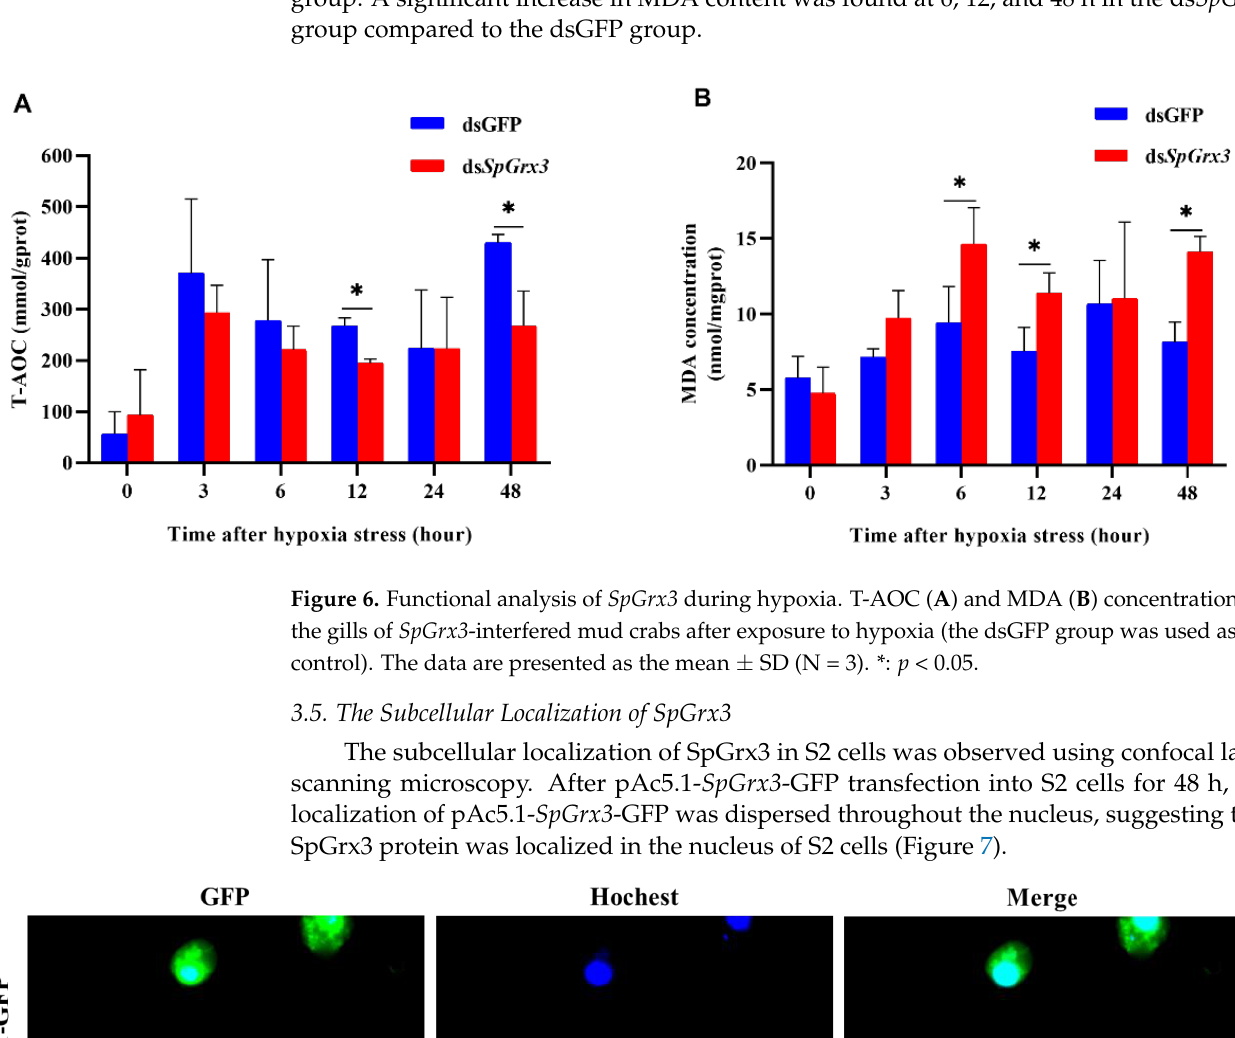
Figure 7. The subcellular localization of SpGrx3 protein in S2 cells. S2 cells were transfected with pAc5.1-GFP (upper row) or pAc5.1- SpGrx3 -GFP (lower row). The cell nucleus was stained with